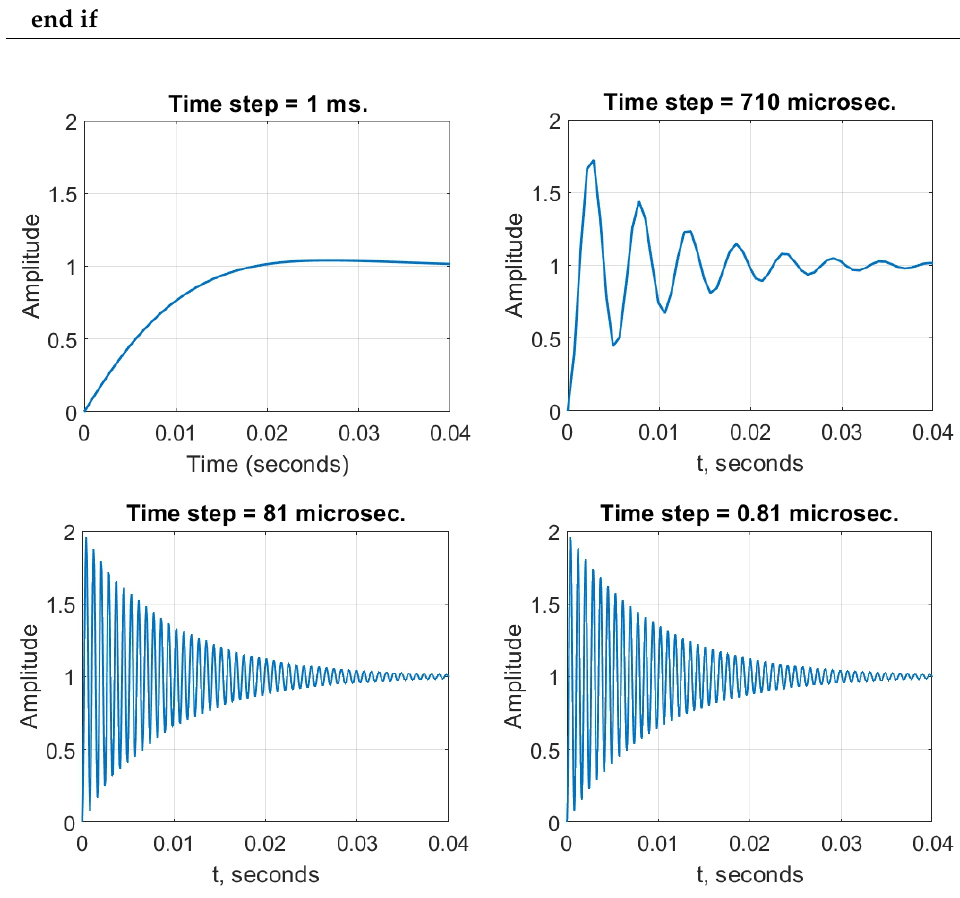
Figure 12. A showcase of modelling a mechanical system without satisfying the Nyquist